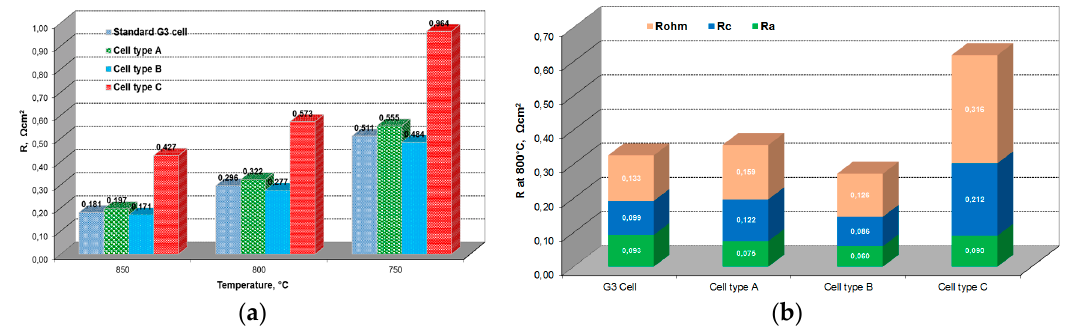
Figure 5. Total area specific cell resistance ( a ) vs. operating temperature and constituents of ASR; ( b ) obtained by the deconvolution of impedance spectra of the cells with different interlayers measured at 800 °C in air: H 2 /H 2 O mixture (50/50) at j = 300 mA/cm 2 in fuel cell mode (without correction to fuel utilization).